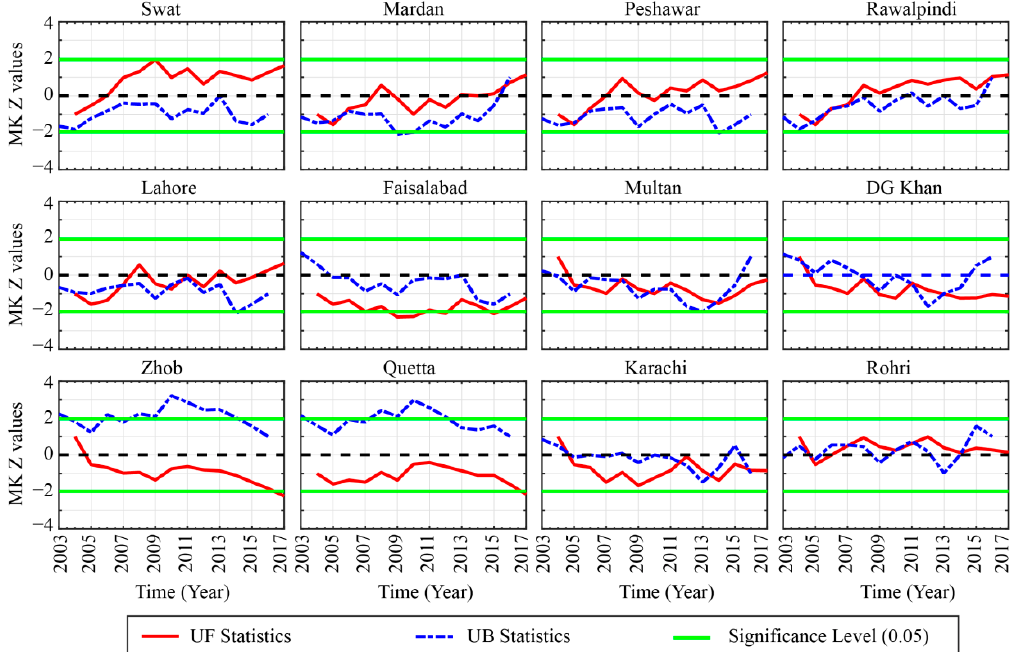
Figure 7. Abrupt changes of summer mean aerosol optical depths during 2003–2017 over the selected locations.